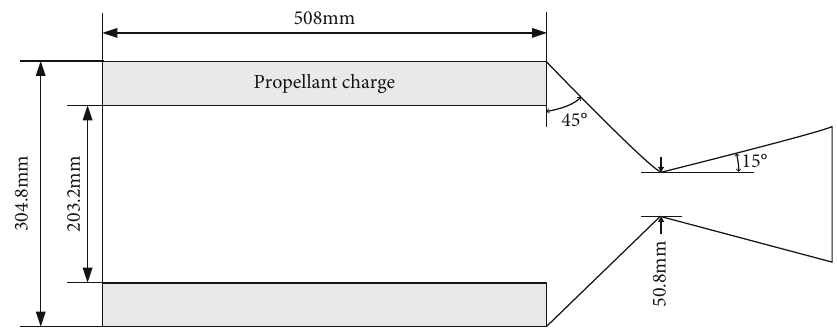
Figure 6: Schematic diagram of the SRM model with tubular charge. Table 1: Propellant